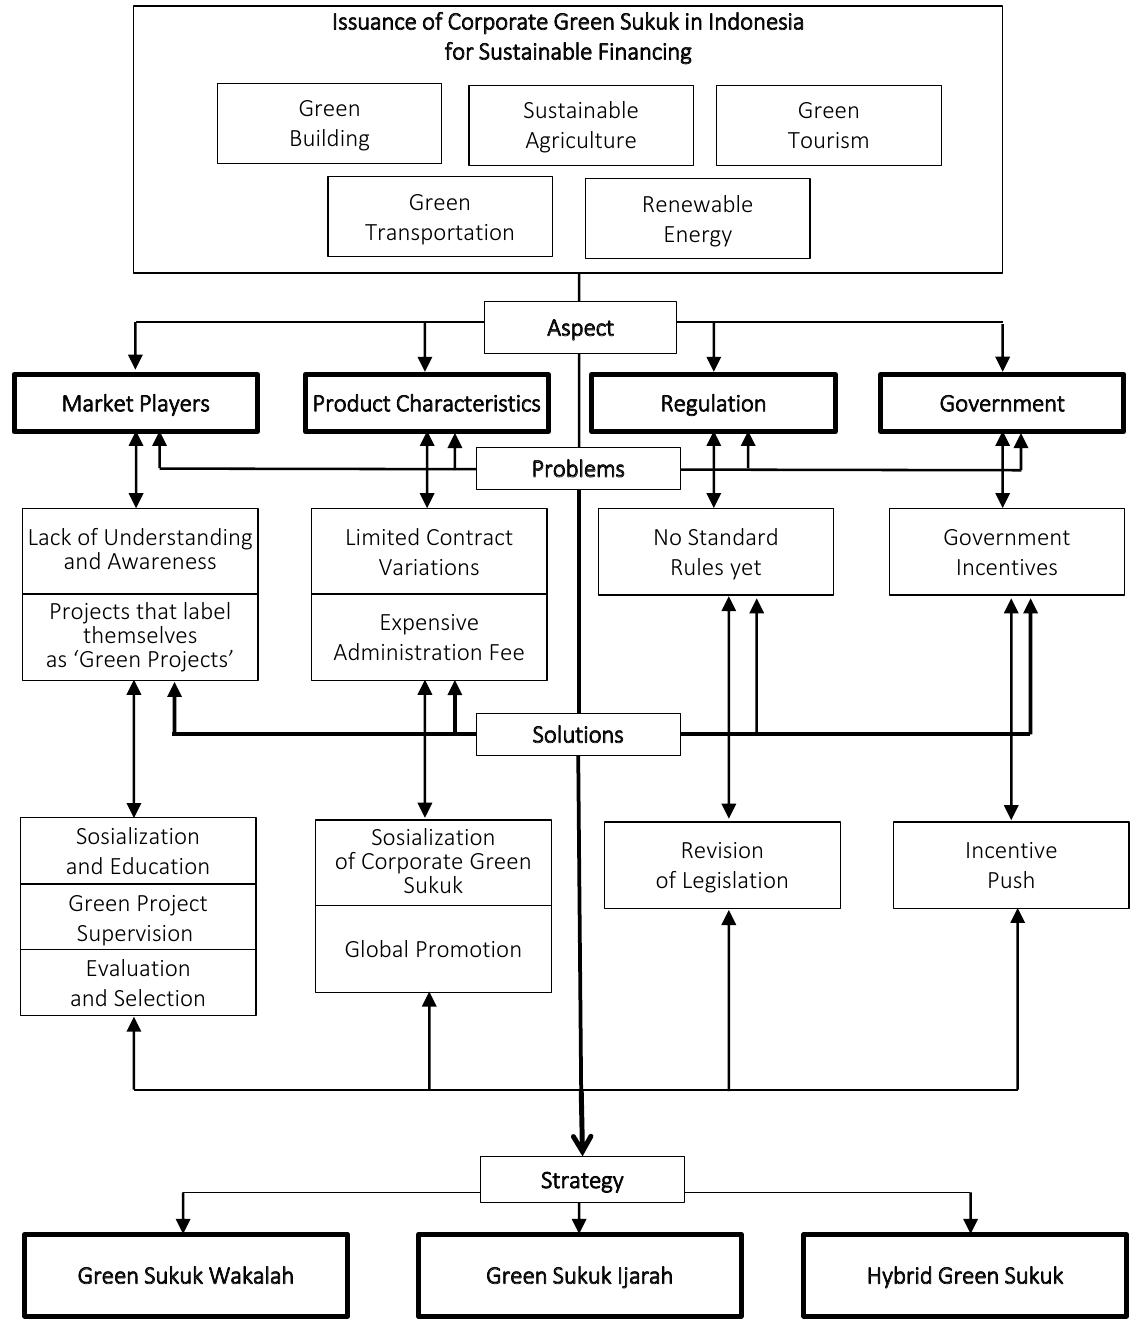
Figure A1. ANP feedback: Network potential for issuing green corporate Sukuk in